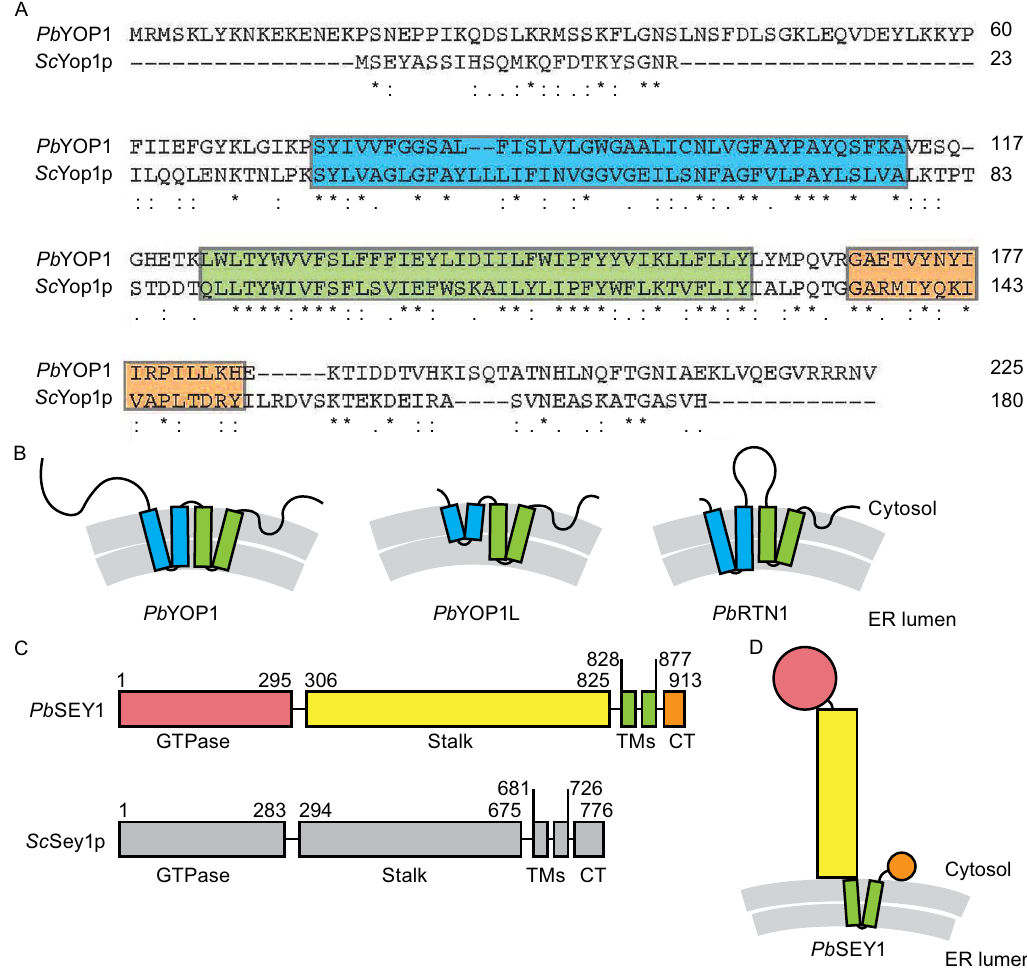
Figure 1. Identi fi cation of Plasmodium ER-shaping proteins . (A) Sequence alignment of P. berghei YOP1 ( Pb YOP1) and S. cerevisiae Yop1p ( Sc Yop1p). Residues are numbered; identical residues are indicated by asterisks and similar residues by dots. The fi rst transmembrane segment is highlighted in cyan, the second in green, and the predicted C-terminal amphipathic helix in orange. (B) Topology diagrams of three ER tubule-forming proteins identi fi ed in the P. berghei genome. Lipid bilayers are shown in gray, the fi rst transmembrane segment in cyan, and the second one in green. The length of each transmembrane segment and loop is shown in proportion to the predicted length. (C) Domain diagrams of P. berghei SEY1 ( Pb SEY1) and S. cerevisiae Sey1p ( Sc Sey1p). Domain boundaries are labeled. TM, transmembrane segment; CT, C-terminal tail. (D) Topology diagram of Pb SEY1. The domains are colored as in